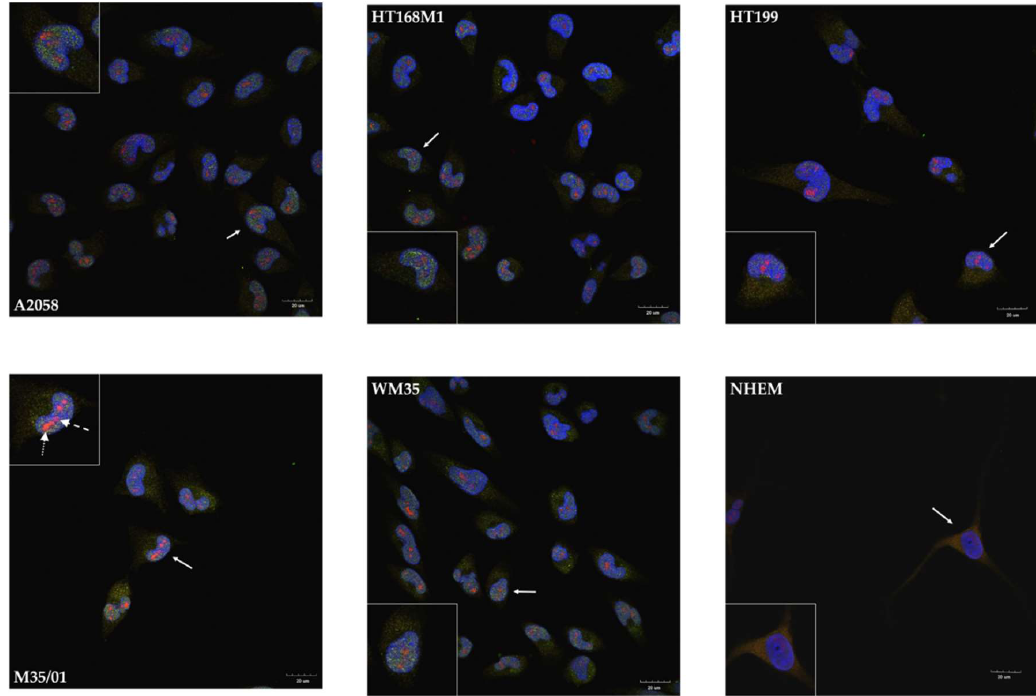
Figure 4. Immunocytochemistry demonstrating nuclear colocalization of NR1-1a and NR3B in melanoma cells. Confocal microscopic analysis demonstrated that NR1-1a (red) shows similar nuclear colocalization in melanoma cells with NR3B (green) as NR1. Nuclei of NHEM showed very weak signals of NR1-1a. NR1-1a was present in the cytoplasmic region of NHEM but unequivocal colocalization with NR3B was not detected at any cellular compartment. As an example, two extra arrows are used in the insert that shows M35/01 cells: the dashed arrow points at an area where the immunofluorescent signal of NR1-1a (red) colocalizes with DAPI (blue), resulting in purple tone whereas the spotted arrow points at an area where NR1-1a colocalizes with DAPI and NR3B (green), resulting in orange colour. Photomicrographs of 1 μm thick optical sections passing through the majority of nuclei in the area of the interest are shown. One representative cell pointed by white arrow with numerous (nuclear) colocalizing signals was selected on each picture and presented in the insert. Scale bar: 20 μm. Positive controls for the secondary antibodies and special controls for the primary antibodies were also performed (See Supplementary Information Figure S8A,B).